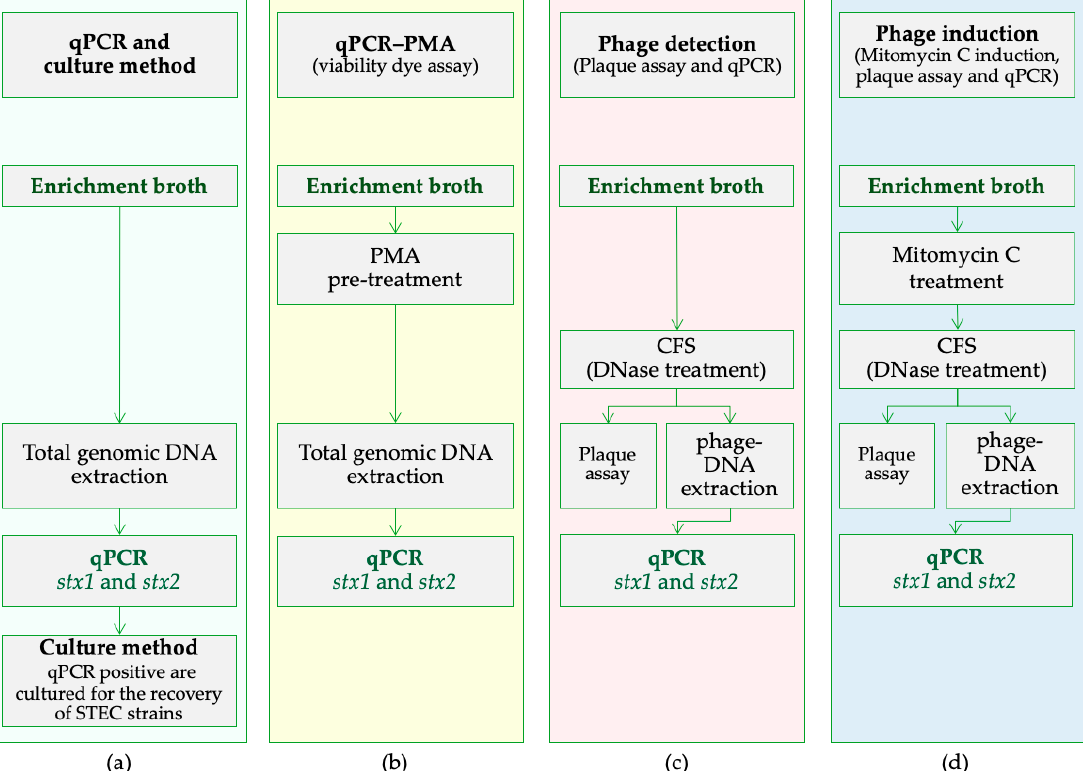
Figure 1. Methods used to investigate the cause of PCR-positive / culture-negative samples for STEC. The methods were applied to the examination of sheep recto-anal junction swab samples. The methods were as follows: ( a ) real-time PCR (qPCR) and culture method; ( b ) propidium monoazide pre-treatment and real-time PCR (qPCR-PMA); ( c ) bacteriophage detection and plaque assay; ( d ) phage induction. qPCR = real-time PCR; CFS = cell free supernatant; PMA = propidium monoazide. Table 1. Primers and probes used for the amplification of stx